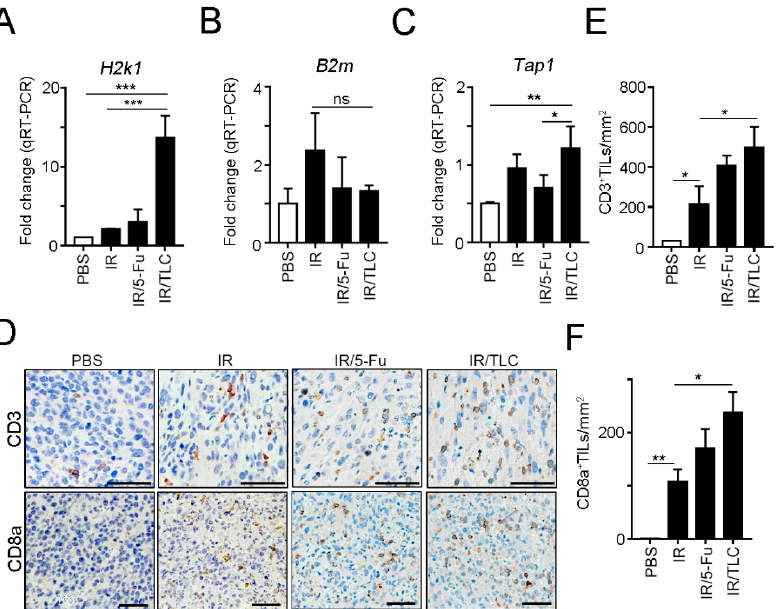
Figure 5. The TLC-based CRT regimen significantly provoked immunogenicity and recruitment of T cells in vivo. ( A ) The level of H2k1 in resected tumors was analyzed by qRT-PCR ( n = 3). *** p < 0.001. ( B ) The level of B2m in resected tumors was analyzed by qRT-PCR ( n = 3). ( C ) The level of Tap1 in resected tumors was analyzed by qRT-PCR ( n = 3). * p < 0.05 and ** p < 0.01. ( D ) The representative results were infiltration of CD3 + TILs, and CD8a + TILs were analyzed by immunohistochemistry ( n = 3). ( E ) The density of CD3 + TILs was counted under high-power-field microscopy ( n = 3). * p < 0.05. ( F ) The density of CD8a + TILs was counted under high-power-field microscopy ( n = 3). Quantitative analysis of the immunoblotting results. * p < 0.05 and ** p < 0.01.